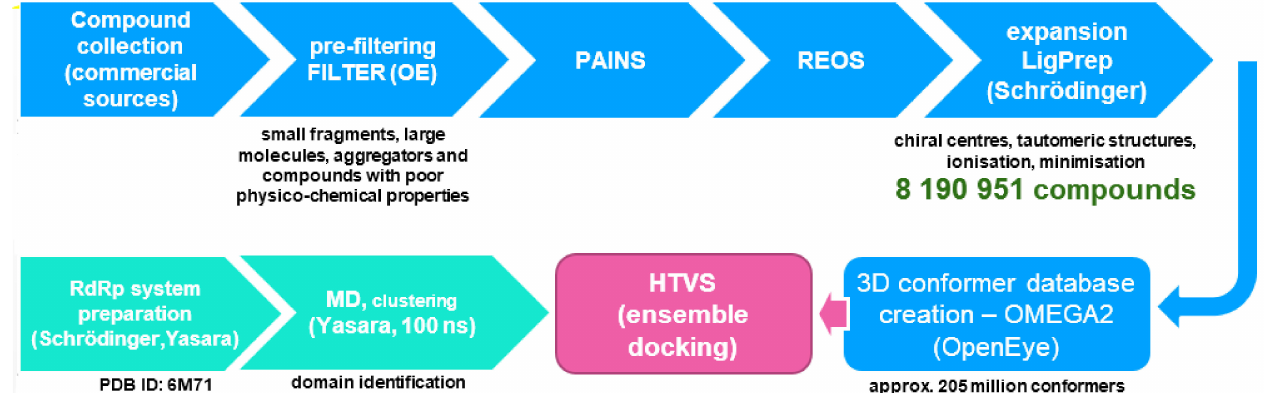
Figure 3. Database preparation for the subsequent high-throughput virtual screening (HTVS) on the SARS-CoV-2 RNA-dependent RNA polymerase (RdRp, PDB ID: 6M71). The final database before conformer generation contained 8 190 951